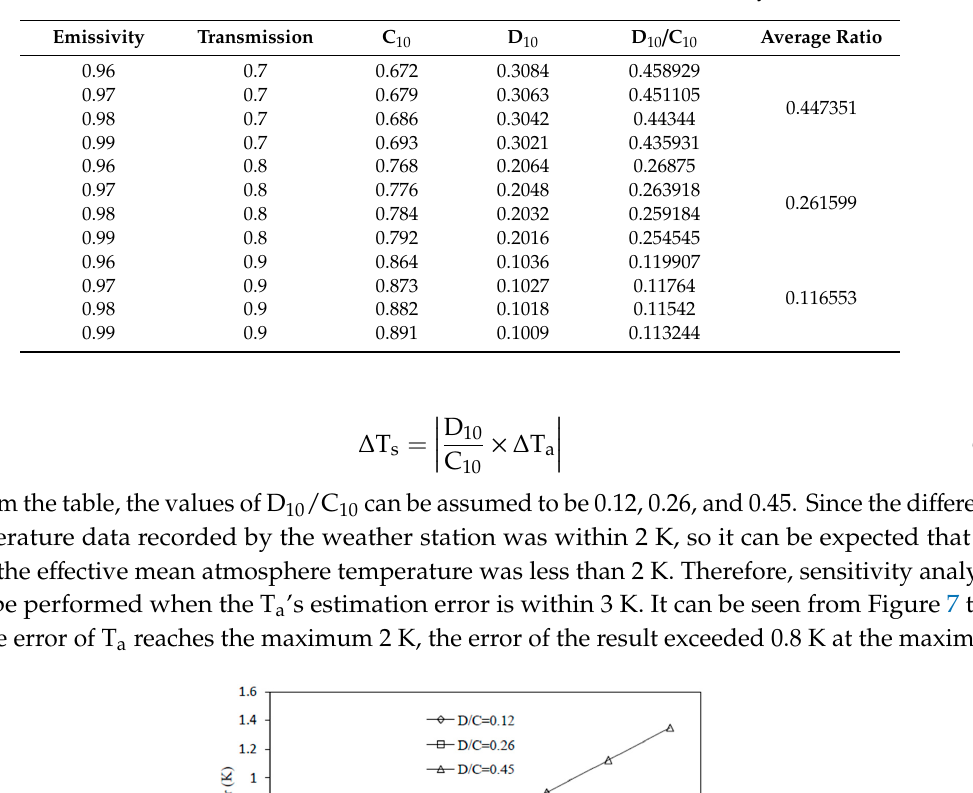
Table 7. The ratio of D 10 /C 10 in the case of di ff erent LSE (Land surface emissivity) and transmission.